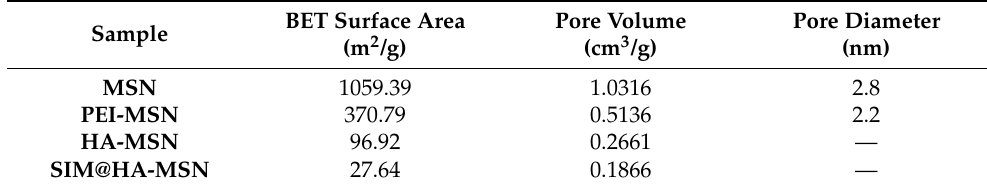
Table 1. BJH and BET analysis of MSN-based